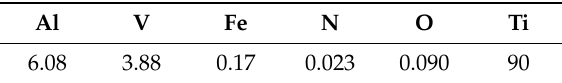
Figure 1. Powder size distribution. Table 1. Powder elemental composition (weight %).